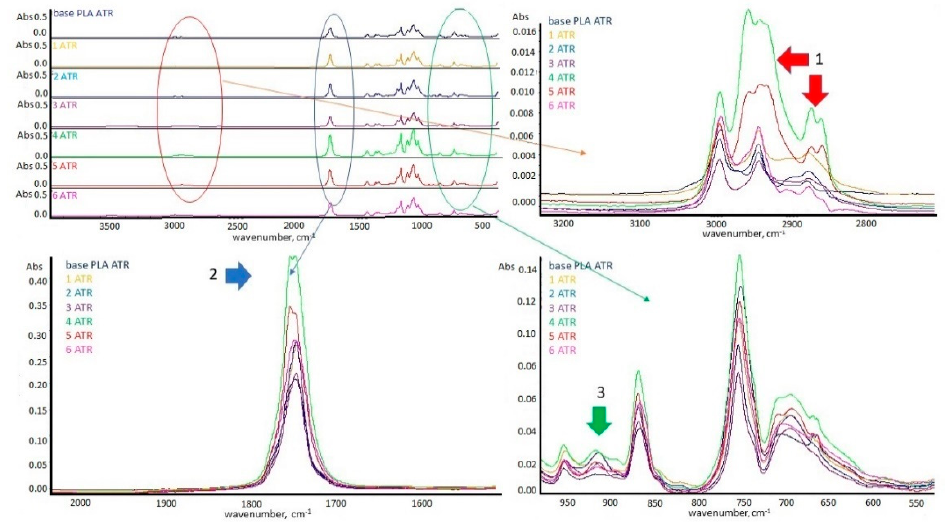
Figure 10. FTIR-ATR spectrum for the plasticized polymers.